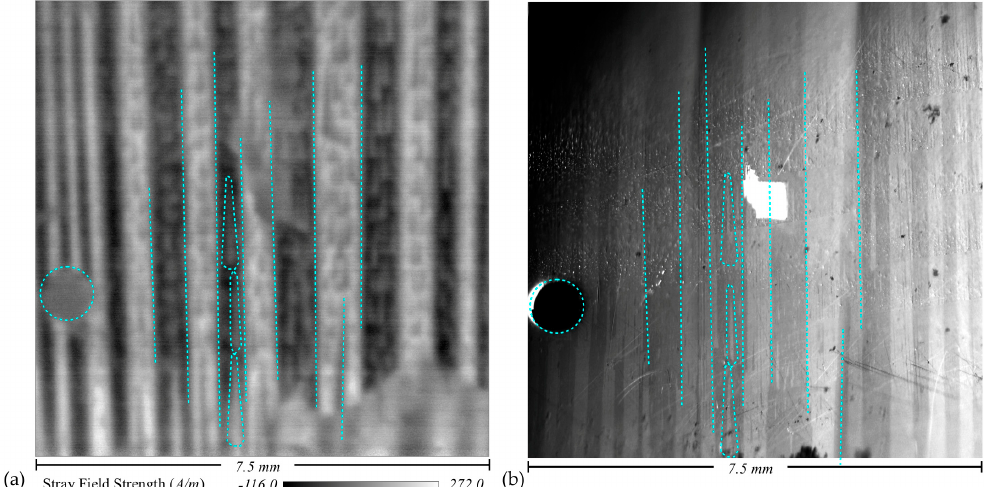
Figure 3. Planar domain observation of stray fields above grain-oriented electrical steel: ( a ) produced by a planar scan with the magnetic field imaging system; ( b ) produced by magneto-optical Kerr effect imaging of the same area of sample. Large bar domains and internal Lancet domains of 50–150 µm are clear. The pinhole used to identify the common area and corresponding magnetic domain features are indicated with blue dotted lines.